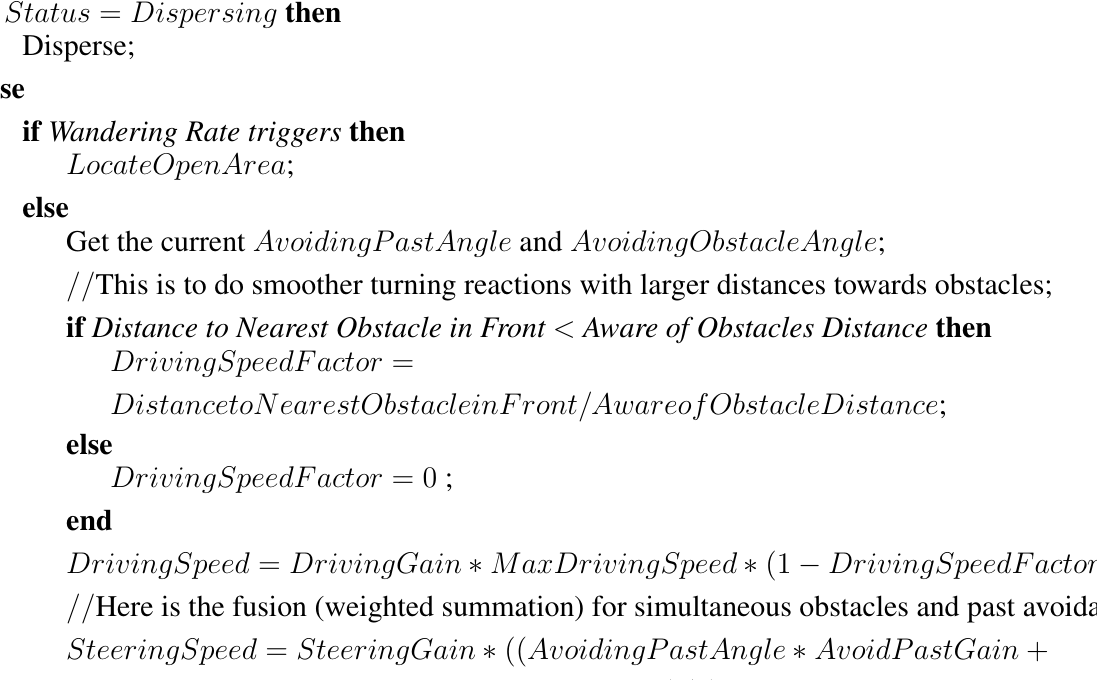
Algorithm 5. Explore